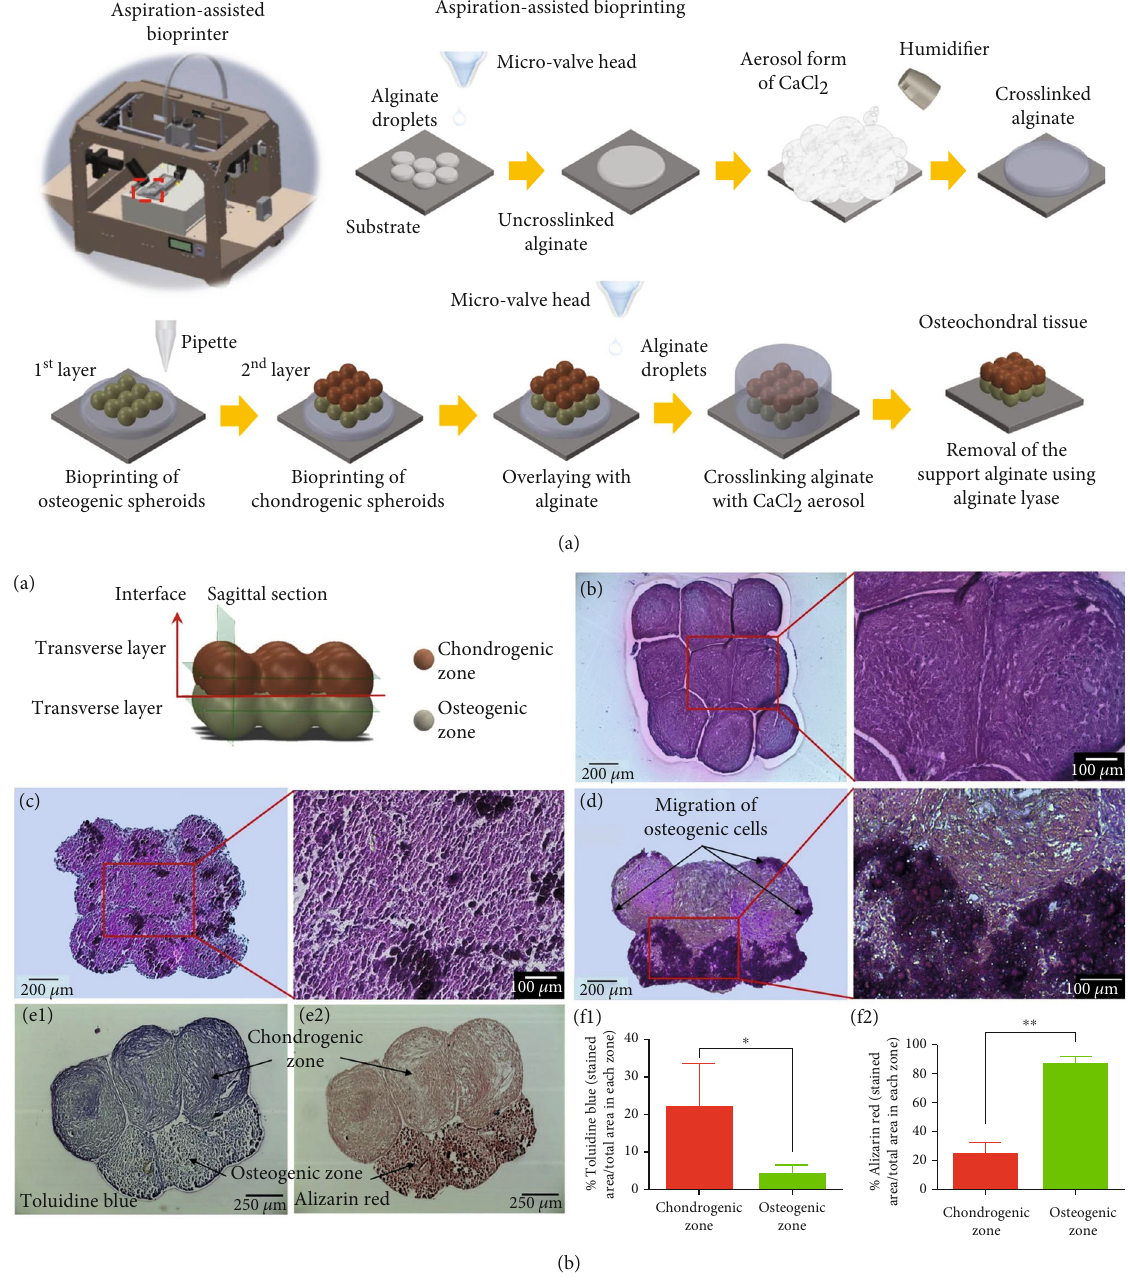
Figure 3: 3D biomanufacture strategy used in stem cell accurate pattern to improve the e ffi ciency of osteochondral tissue recapitulation. (a) Aspiration-assisted bioprinting process of osteochondral (OC) interface. (b) Characteristics of the bioprinted OC interface and the zone of cartilage and subchondral bone. Reproduced with permission [26,